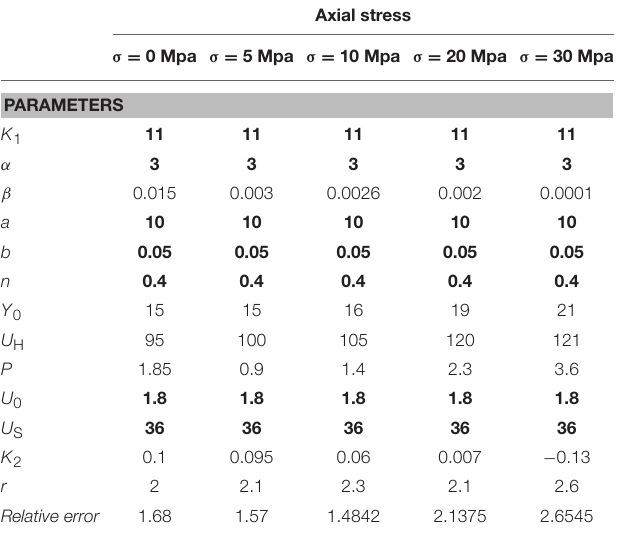
TABLE 2 | Human-driven method: identified parameters.